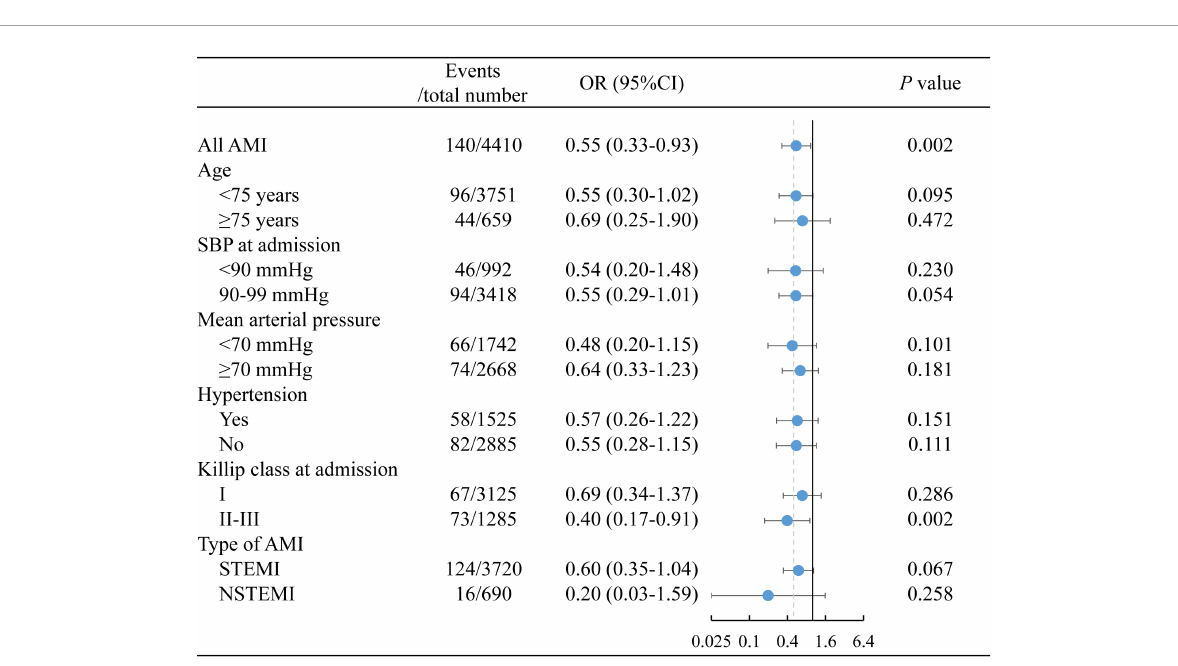
patients with no ACEIs/ARBs or β -blockers, patients using only ACEIs/ARBs (OR: 0.39, 95% CI: 0.17–0.90; p = 0.028), those using only β -blockers (OR: 0.62, 95% CI: 0.39–0.98; p = 0.041), and those using both ACEIs/ARBs and β -blockers (OR: 0.46, 95% CI: 0.25–0.85; p = 0.014) all exhibited a significantly reduced risk of MACEs ( Figure 3B ).